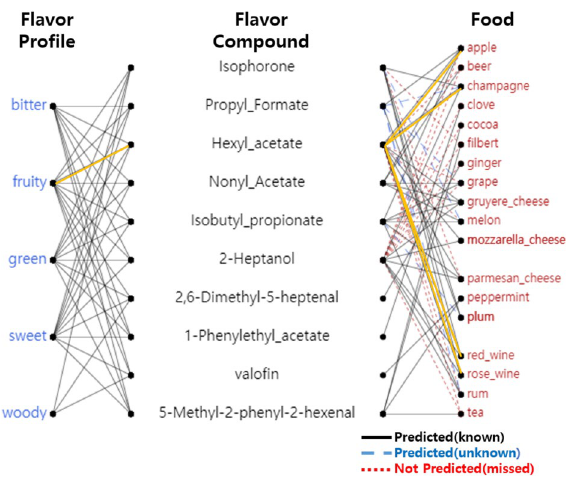
Figure 5. <Flavor profile-Flavor compound-Food> relation network.